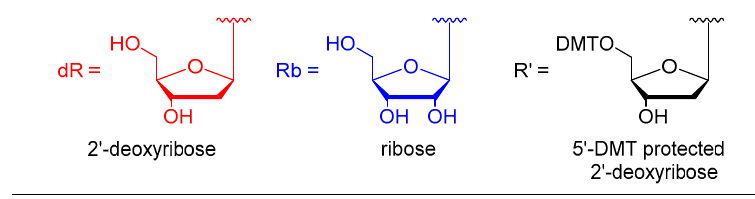
Figure 3. Structures abbreviation.